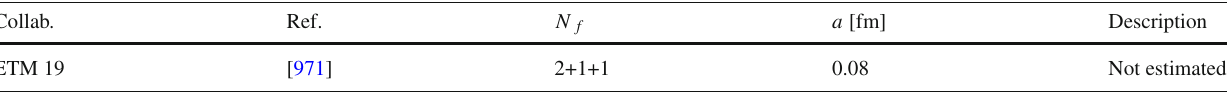
Table 189 Continuum extrapolation/estimation of lattice artifacts in direct determinations of σ π N and σ s Collab.